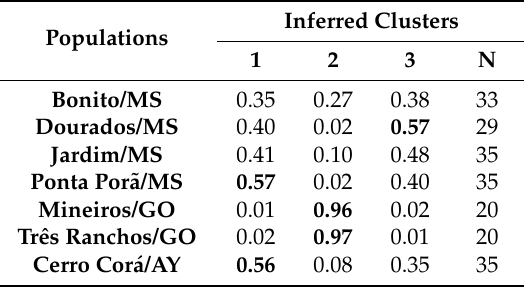
Table 4. Number of individuals (N) per population and proportion of the association of each population in each of three groups inferred by the STRUCTURE program. Associations greater than 0.5 are in bold.